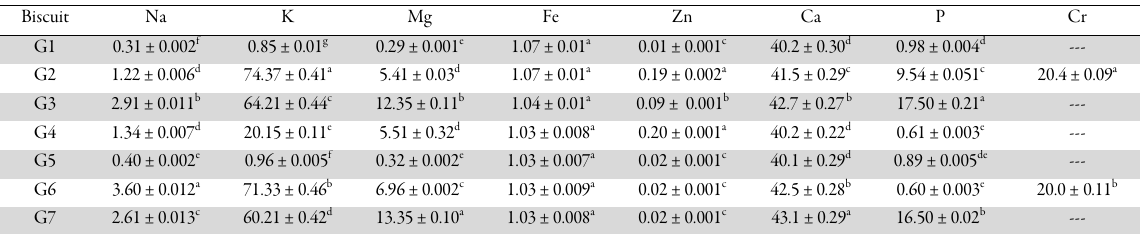
Table 10. Element contents of the colored barley flour biscuit made using the natural color and synthetic color (mg /100g dry weight) Biscuit Na